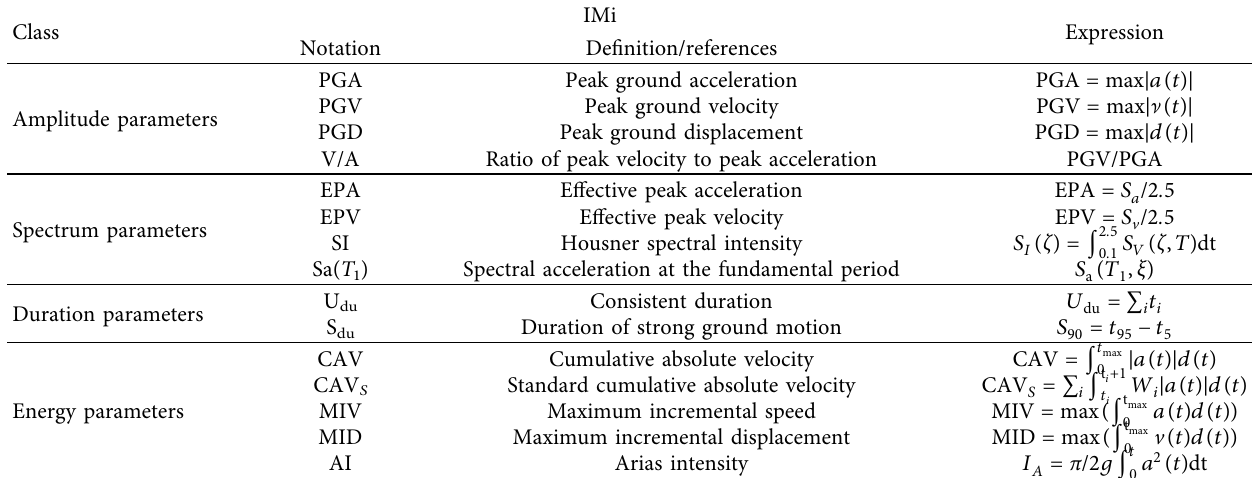
Table 2: IMs considered in this study.